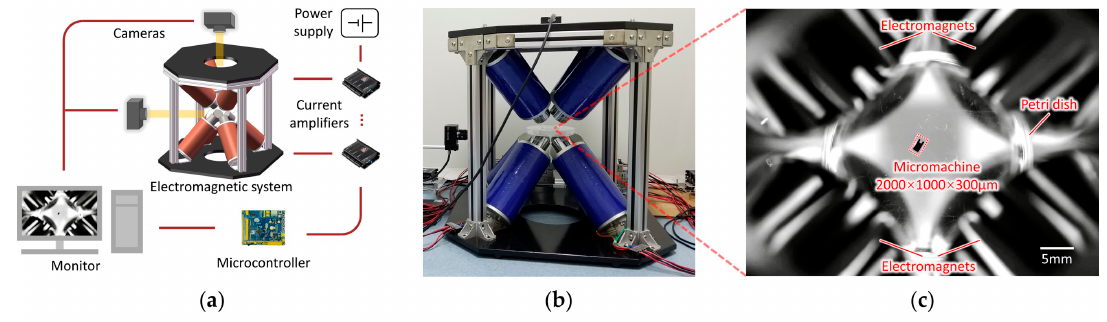
Figure 3. ( a ) Schematic of the external electromagnetic system. ( b ) Photograph of the eight-coil system. ( c ) Image of the micromachine in the workspace from the top camera.